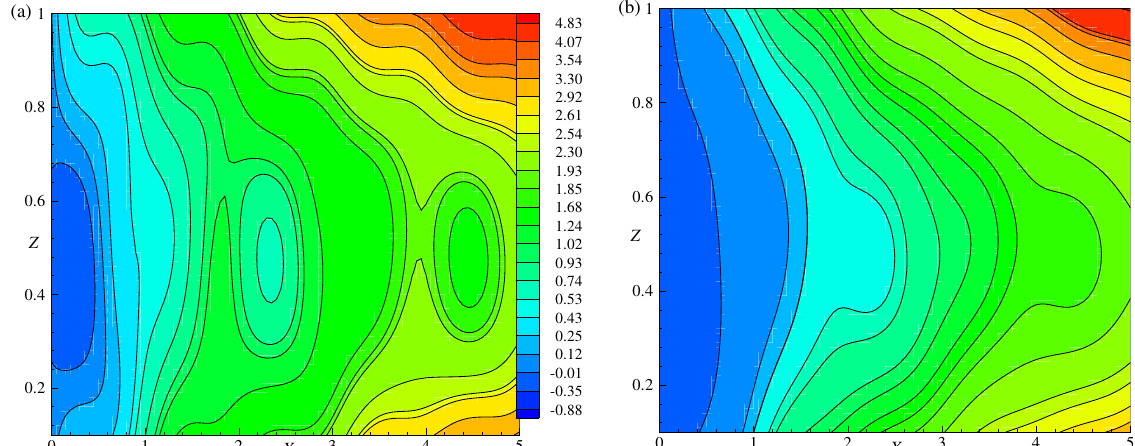
Figure 15. Heatlines for ψ = − 0.02 ( a ) and − 0.01 ( b ) at Le = 0.04, χ = 0.2, t = 0.8, R = 3 R co